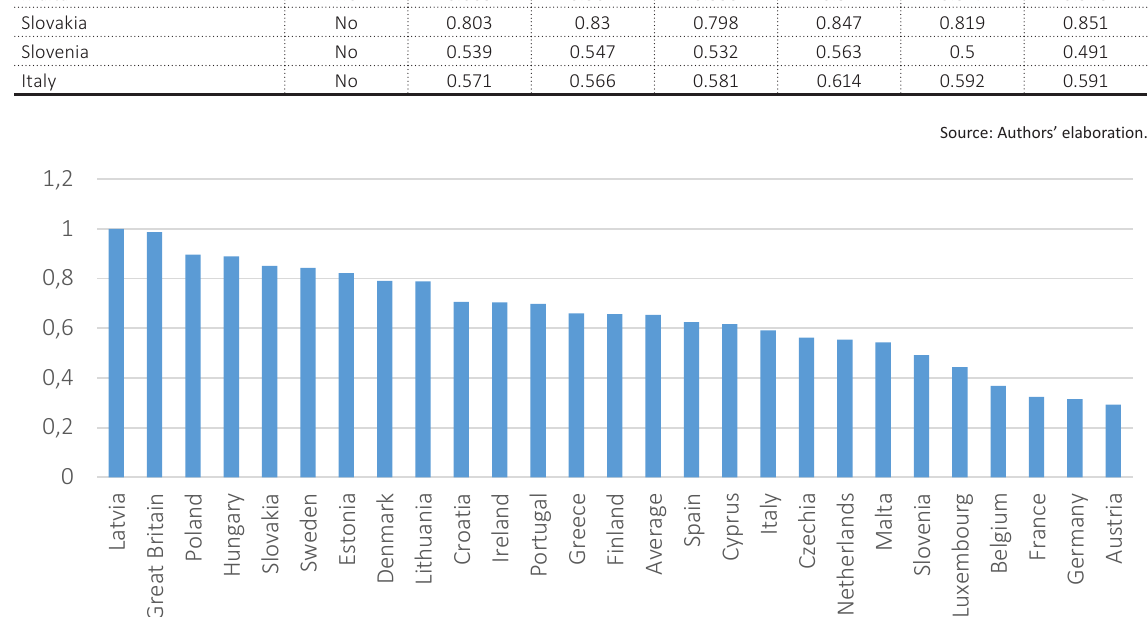
Figure 1. ThetaOpt value in selected EU countries according to the selected